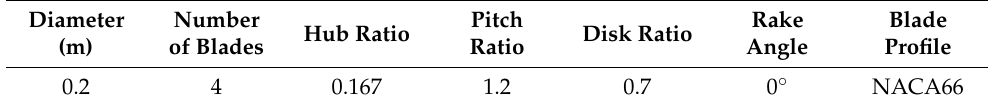
Table 4. Parameters of the duct propeller.